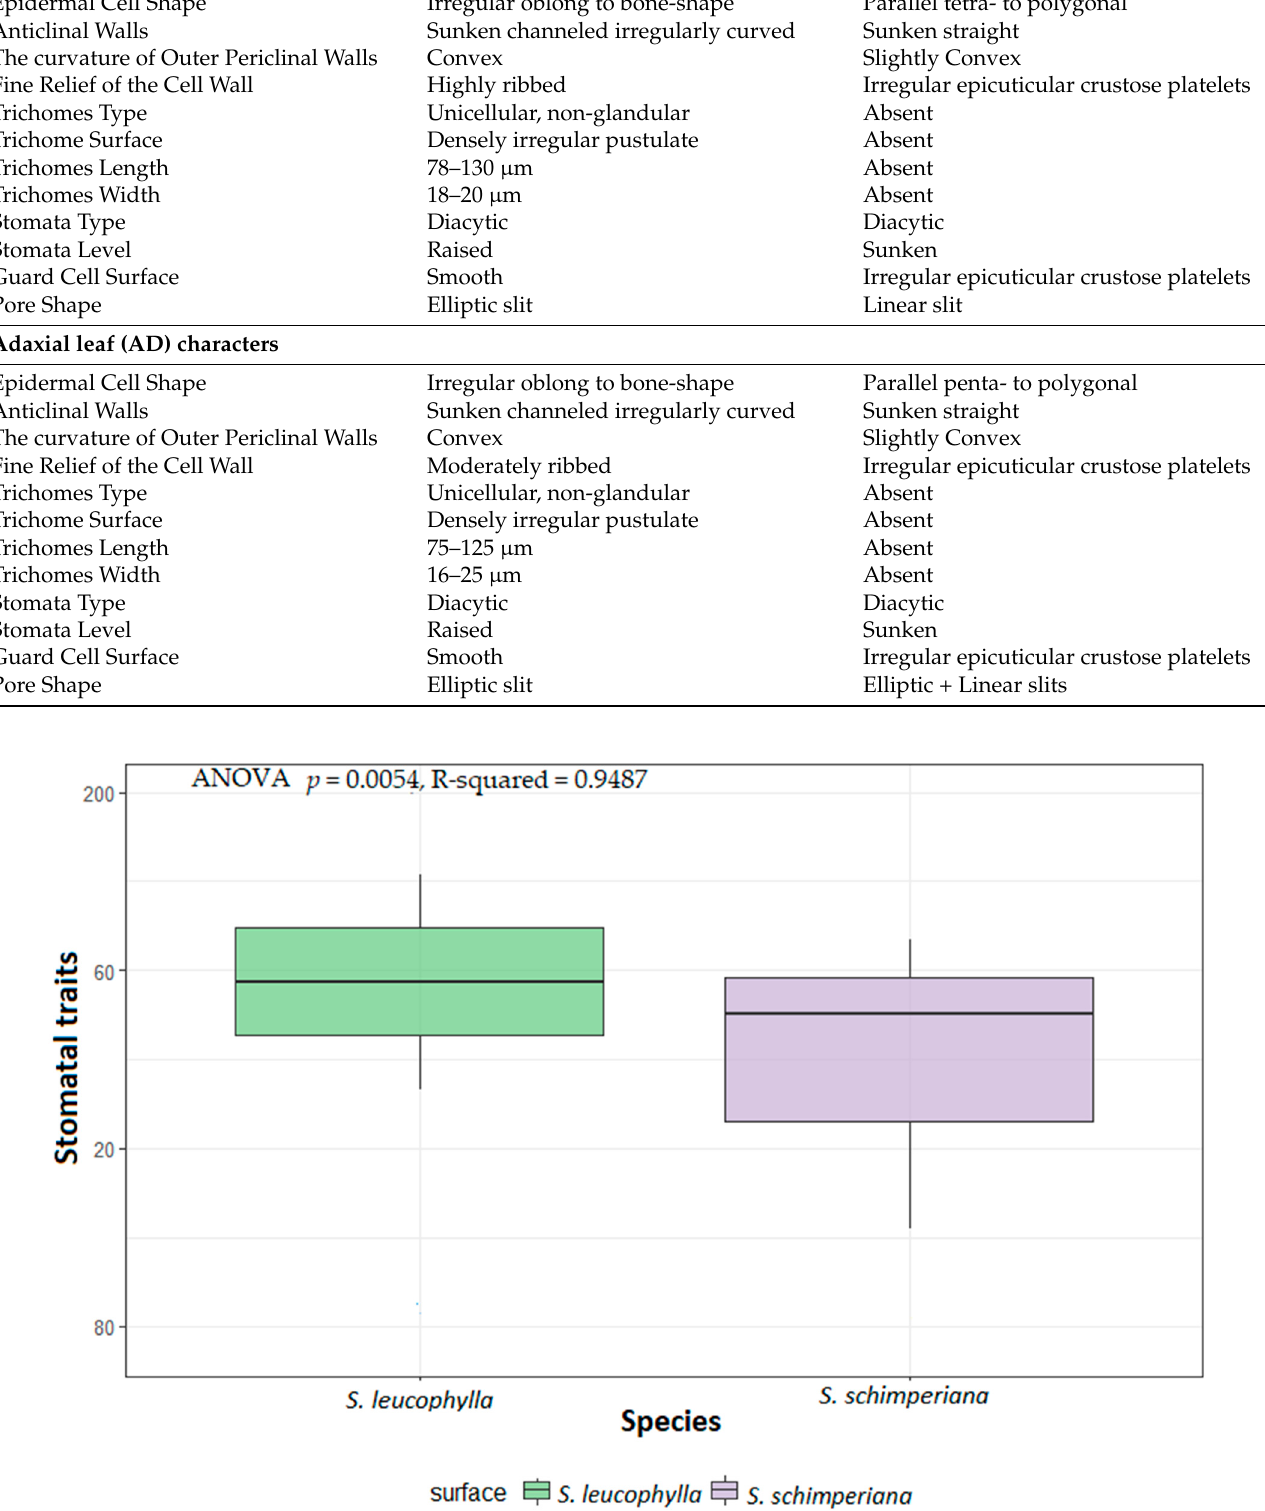
The leaf epidermal cells of the adaxial (AD) and abaxial (AB) surface of S. leucophylla were oblong, bone-shaped, and irregularly arranged. On the other hand, in S. schimperi- ana , the AD and AB surfaces’ epidermal cells were “tetra-, penta-, hexa-, and polygonal” parallelly arranged (Figure 3).